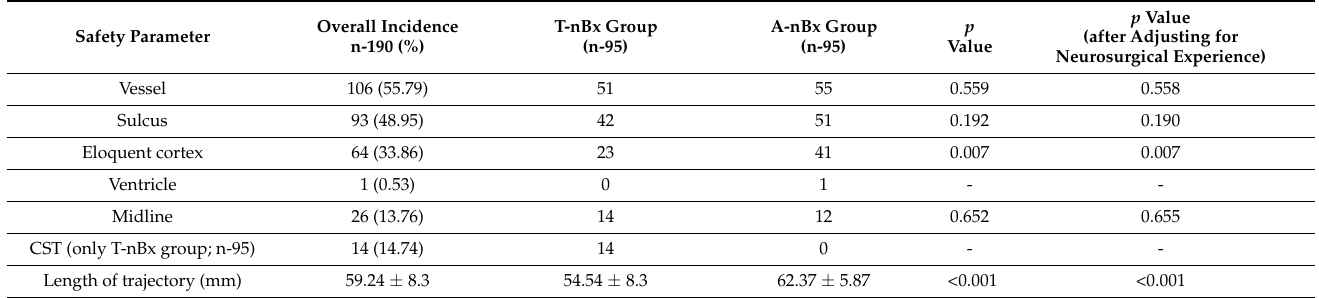
Table 2. Trajectory Safety index Analysis.